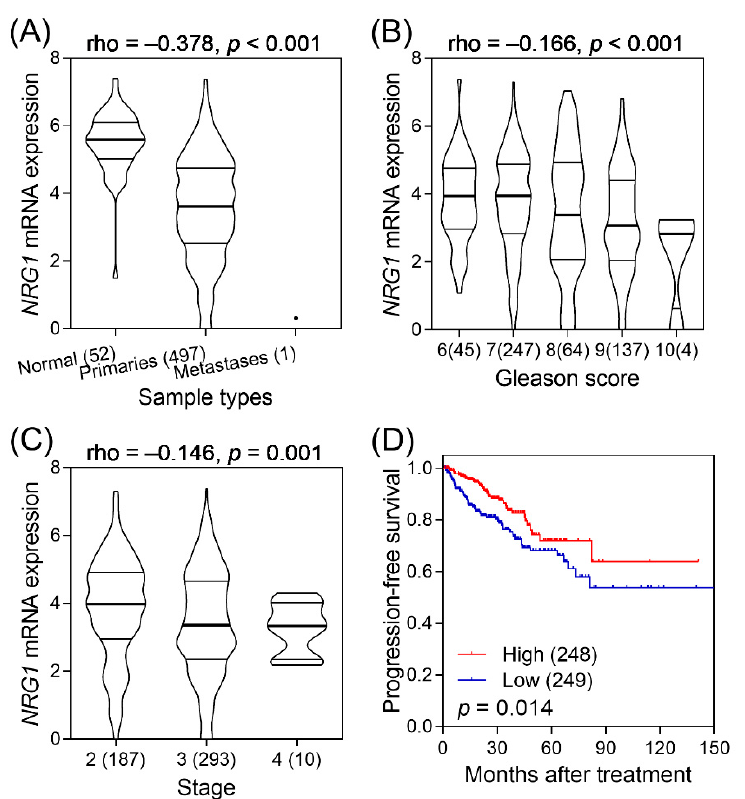
7 of 12 Figure 3. Correlation between rs144160282 genotypes and NRG1 expression. Data were calculated using HapMap3 lymphoblastoid cell data. Values in brackets represent the number of samples. The clinical relevance of NRG1 in prostate cancer was further assessed using a TCGA PRAD dataset. As shown in Figure 4, the expression level of NRG1 mRNA de- creased in prostate cancer as compared to adjacent noncancerous tissues ( p < 0.001). Further, it also decreased with increasing Gleason score ( p < 0.001) and with higher tumor stage ( p < 0.001). Lower NRG1 expression was associated with significantly poor PFS in